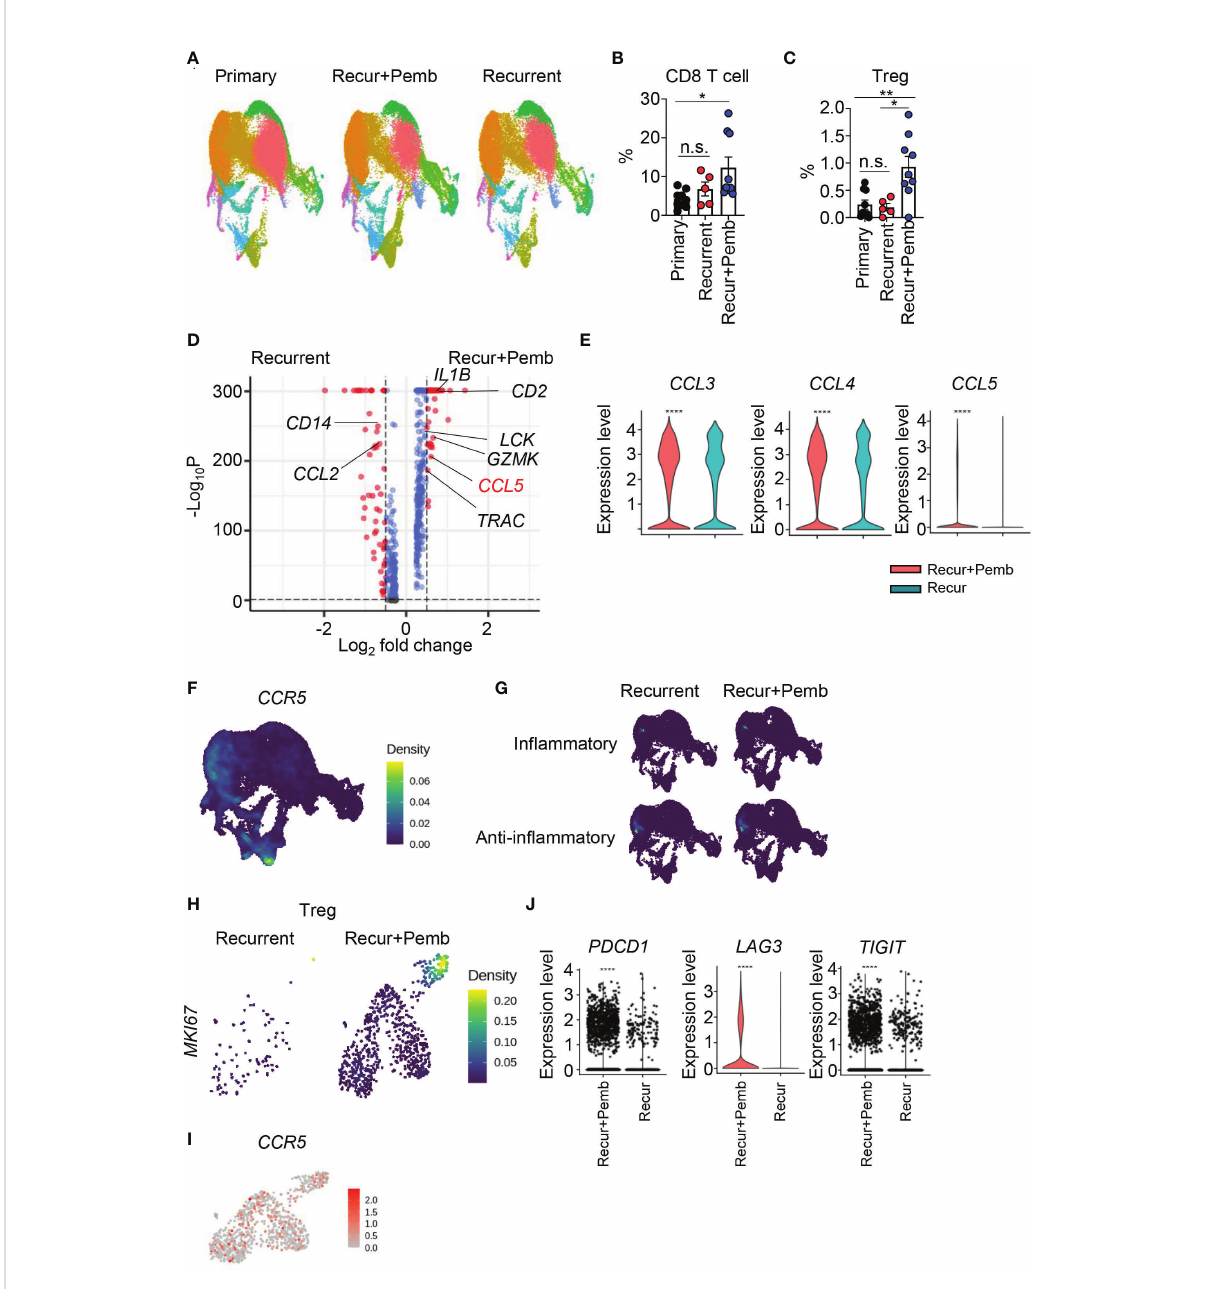
FIGURE 7 Neoadjuvant pembrolizumab treatment in patients with recurrent GBM induces the CCL5 – CCR5 axis. (A – I) scRNAseq data from the GSE154795 dataset of tumor tissues from patients with primary GBM, recurrent GBM, and recurrent GBM+pembrolizumab were re-analyzed. (A) Cells were subjected to UMAP, and differences in clusters are displayed. Frequencies of CD8 T cells (B) and Tregs (C) among total cells were calculated. DEGs in total cells between patients with recurrent GBM and patients with recurrent GBM+pembrolizumab were analyzed. (E) The expression of CCL3 , CCL4 , and CCL5 in total cells was compared between patients with recurrent GBM and patients with recurrent GBM+pembrolizumab. Expression densities of CCR5 (F) and in fl ammatory genes ( CD86 , CD80 , CXCL10 , IL1B , TLR2 , TNF , IL6 , IL12A , NOS2 ) and anti-in fl ammatory genes ( TGFBI , IL1RN , IL10RB , CD274 , IL4R , MSR1 , TGFB1 , IL6ST ) (G) are shown. (H) The expression density of MKI67 in Tregs. (I) Feature plot for CCR5 expression of Tregs. (J) The expression of PDCD1, LAG3 , and TIGIT in CD8 T cells was analyzed. Data in (B, C) were analyzed by unpaired, two-tailed Student ’ s t test. Data in (E , J) were analyzed by the stat_compare_means function with unpaired t-test. * P <0.05, ** P <0.01, *** P <0.001, **** P <0.0001. Error bars represent the mean ± standard error of the mean (SEM). ns, not signi fi